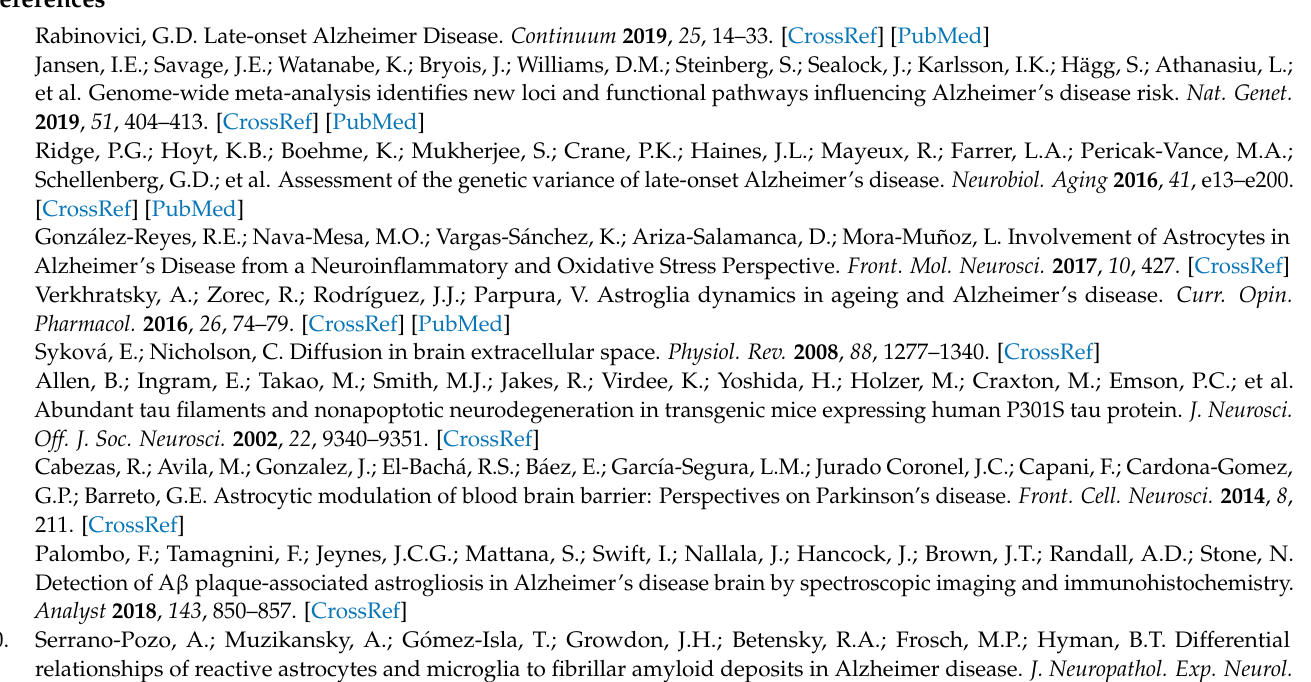
cells. Figure S2: Spontaneous calcium transients in iPSC-derived astrocytes. Figure S3. Blocking of HSPG with heparin mitigates the effect of tau proteins on sAD and fAD iPSC-derived astrocytes. Figure S4: Degradation of tau at 6 h by astrocytic MMPs. Figure S5: Neurons from healthy NDCs with or without conditioned medium from NDC, sAD and fAD astrocytes. Figure S6: Represen- tative images of neurons from healthy NDCs with or without conditioned medium from NDC, sAD and fAD astrocytes after glutamate stimulation. Supplementary Table S1: Clones used in the study. Movie S1: NDC_Astrocytes_Glutamate stimulation.mov. Movie S2: